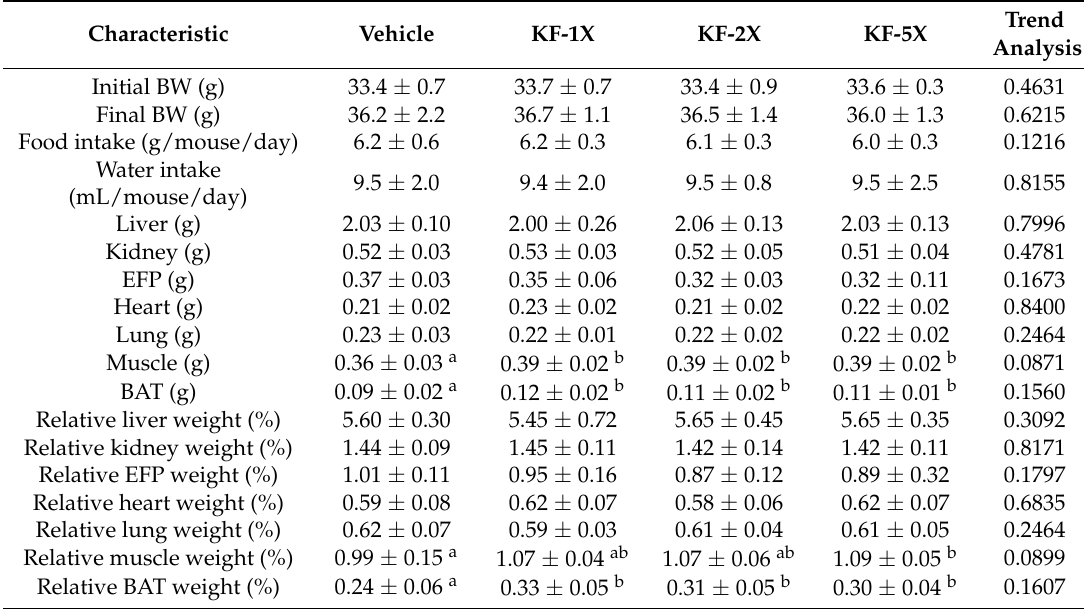
Table 1. General characteristics of mice with kefir (KF) supplementation.